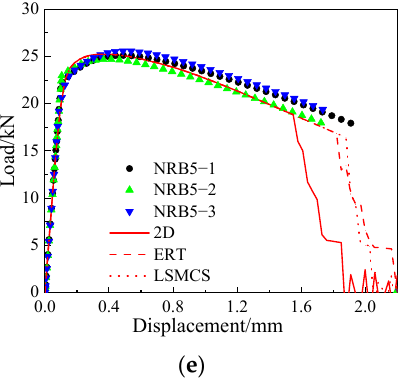
Figure 14. Comparison between finite element and experimental fracture: ( a ) CH6, ( b ) FS, ( c ) NRB1, ( d ) NRB3, and ( e ) NRB5.